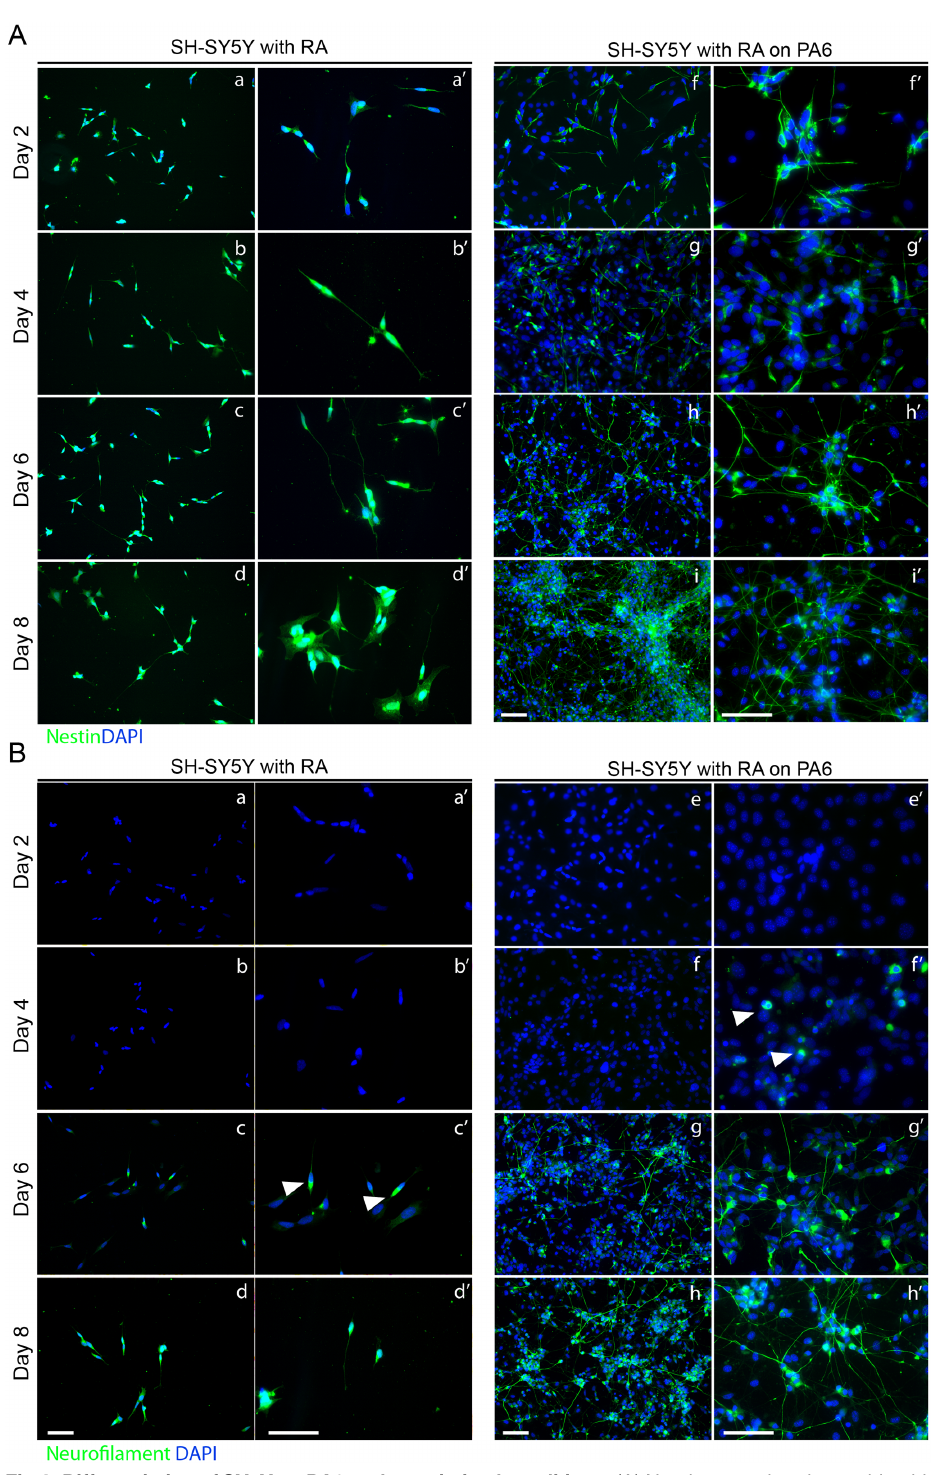
Fig 4. Differentiation of SY5Y on PA6 under optimised conditions. (A) Neurites are already considerably extended by day two when compared to RA alone (f) with much more extensive networks can be seen by day eight (i). Nestin staining appears less intense on day eight compared to day six (h) potentially indicating expected decreased expression on maturation. (B) Neurofilament expression can be seen first in the cell body on day six of differentiation without PA6 (c, arrows). With PA6 however, this is first seen on day four